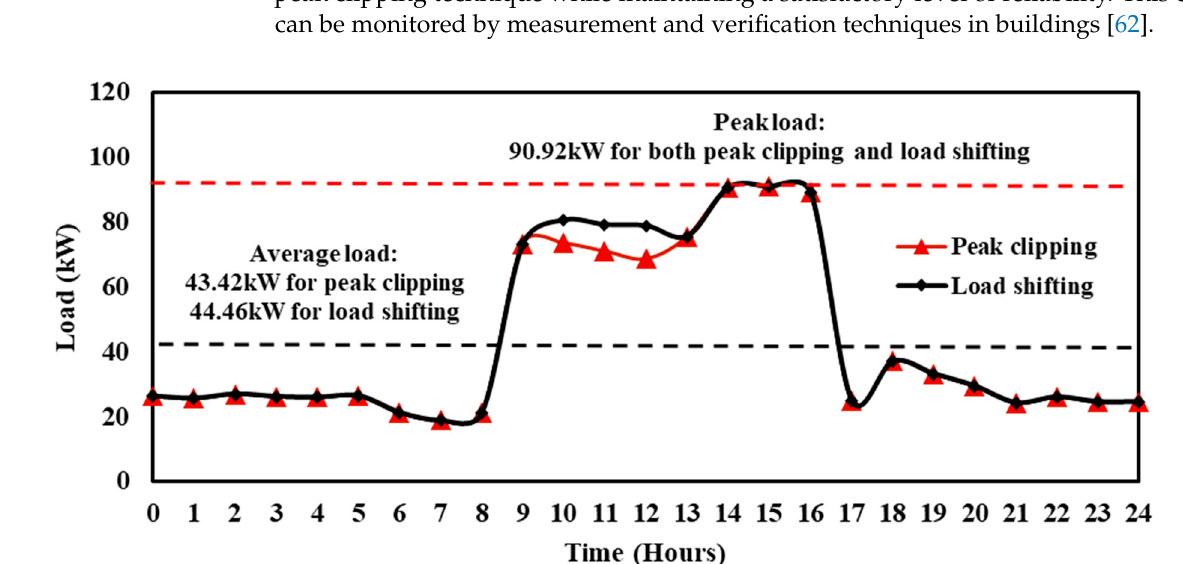
Figure 9. Comparison of load factor—before and after DSM from daily and monthly load profile curve.